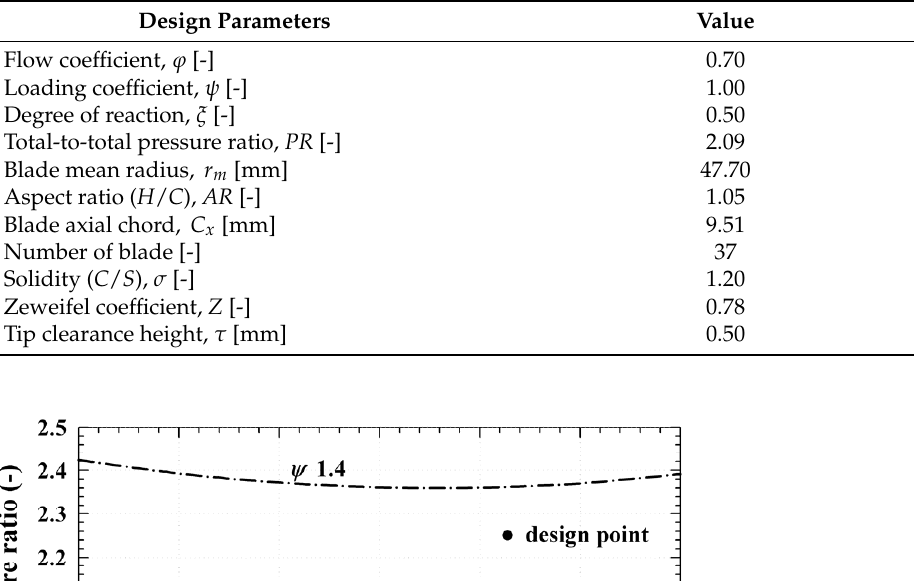
Table 4. Mean-line design results for rotor blade of single-stage axial-flow turbine.